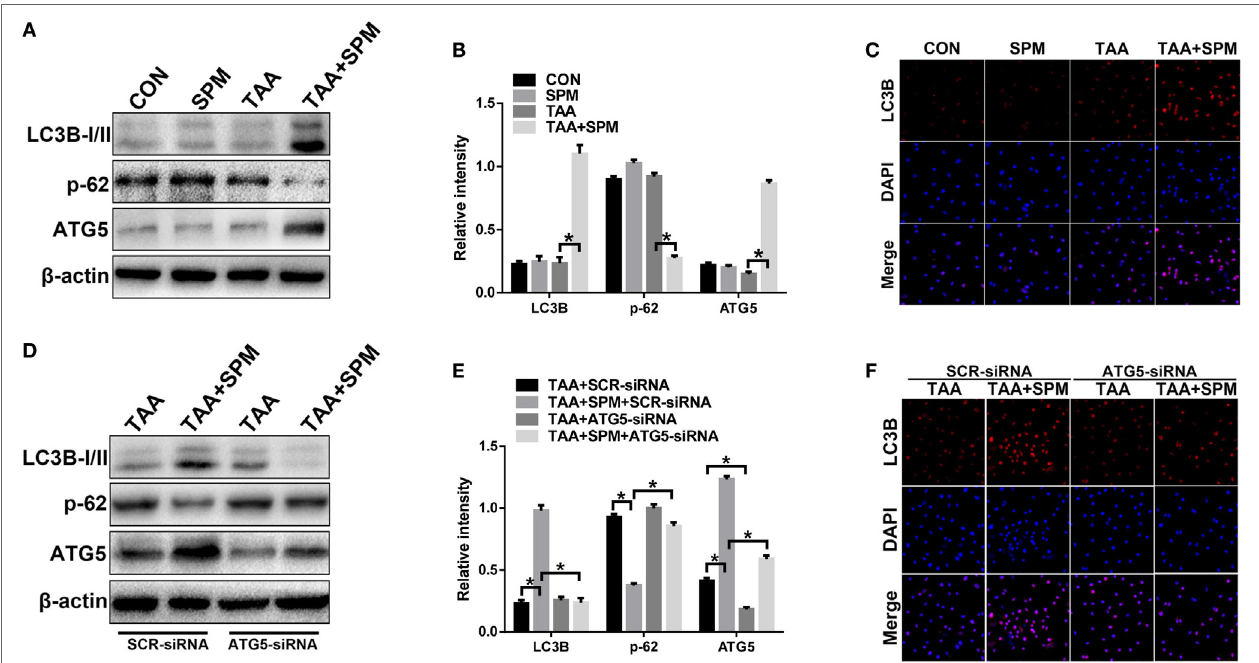
FigUre 4 | Spermine (SPM) induces KC autophagy after thioacetamide (TAA) treatment. Mice were subjected to SPM pretreatment and TAA administration as described in Section “Materials and Methods.” KCs were isolated from different experimental groups, and intracellular LC3B, p-62, ATG5, and β -actin protein levels were measured by Western blot. Representative of three experiments (a) . Relative density ratios of target proteins in different experimental groups compared to the control group (CON) were calculated [ (B) , n = 3/group]. Immunofluorescence staining of LC3B in KCs (original magnification 20 × ). DAPI was used for nuclear staining [ (c) , n = 6/group]. Both TAA and TAA + SPM mice were pretreated with ATG5 siRNA (ATG5-siRNA) or its scrambled control siRNA (SCR-siRNA) in vivo prior to TAA administration using mannose-conjugated polymers as described in “Materials and Methods.” KCs were isolated from different experimental groups and the intracellular LC3B, p-62, ATG5, and β -actin protein levels were measured by Western blot. Representative of three experiments (D) . Relative density ratios of target proteins in different experimental groups compared to the control group (CON-SCR-siRNA) were calculated [ (e) , n = 3/group]. Immunofluorescence staining of LC3B in KCs (original magnification 20 × ). DAPI was used for nuclear staining [ (F) , n = 6/group] (* p <